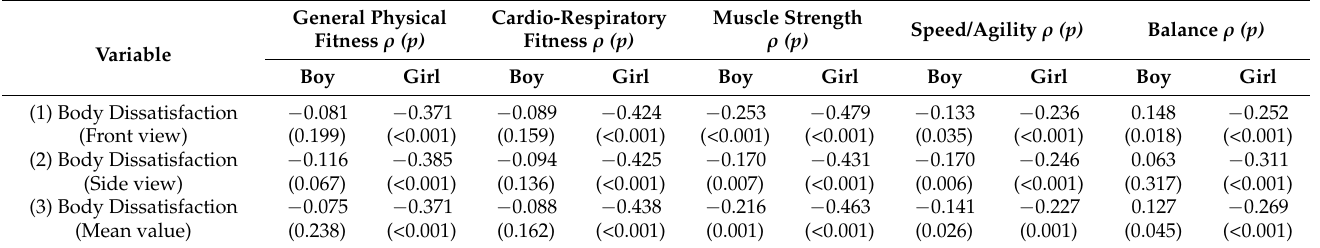
Table 2. Correlation between body dissatisfaction and perceived physical ability.